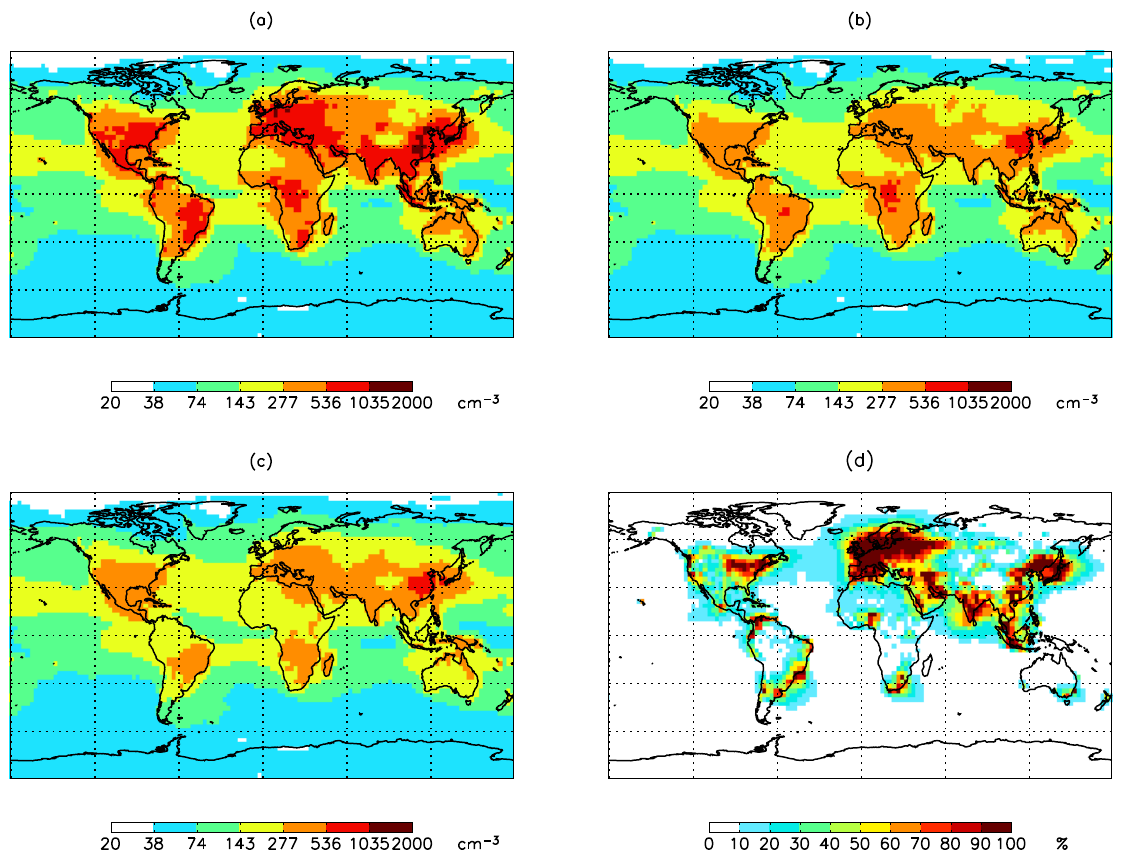
Fig. 4. Simulated all-sky annual mean cloud droplet number concentrations (CDNC) at the surface. (a) With carbonaceous combustion aerosol, (b) without pollution (fossil fuel and biofuel) carbonaceous combustion aerosol emissions, (c) without carbonaceous combustion aerosol emissions. (d) Percentage change in CDNC due to pollution carbonaceous combustion aerosol emissions. All results are for a cloud updraft velocity of 0.4ms − 1